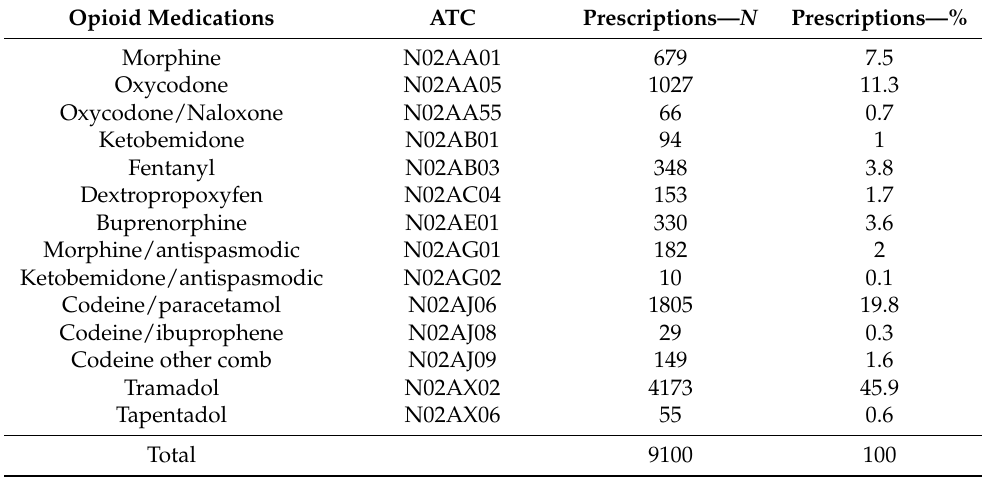
Table 1. Opioids prescribed to the total sample ( N =